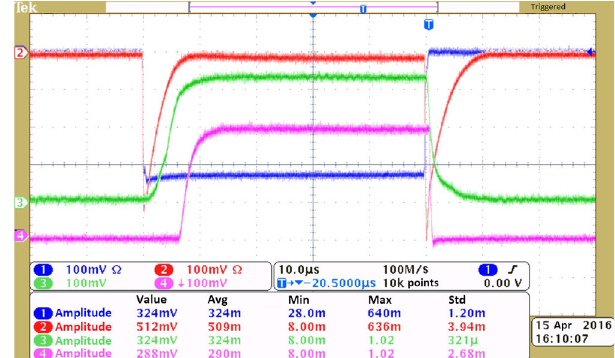
13. Normal operation of CPHS linac. (blue line: input power fed into the RFQ; red line: reflected power of the RFQ; purple line: ACCT signal at the exit of the RFQ; green line: ACCT signal at the exit of the HEBT line.